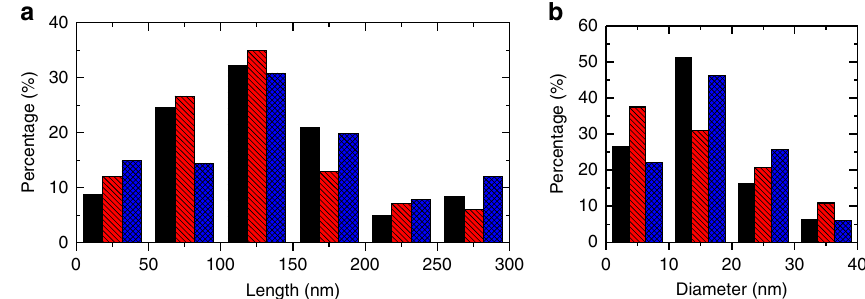
Fig. 5 The length and diameter distributions of T-carbon nanowires produced using different laser powers. a Length distribution. b Diameter distribution. Black = 75 mW, red = 85 mW, blue = 95 mW